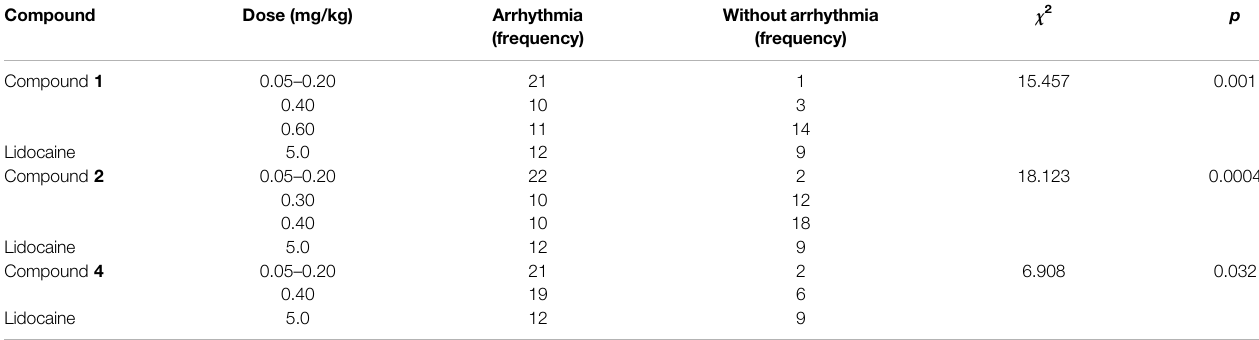
TABLE 7 | Chi-square analysis of arrhythmia inhibition rate between different experimental compounds and lidocaine. Compound Dose